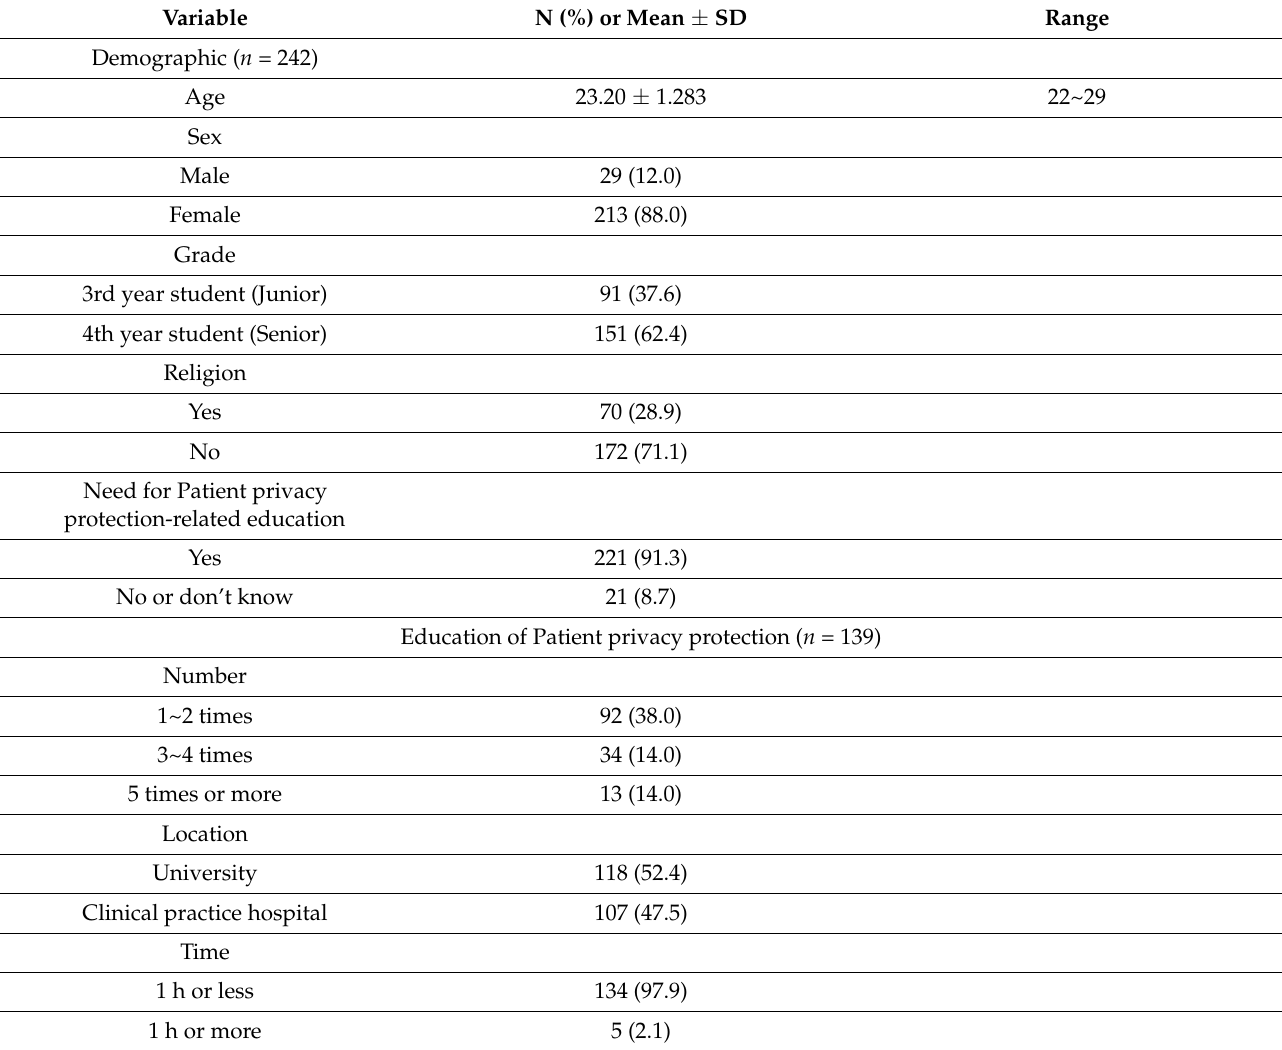
Table 1. General characteristics and patient privacy protection education (N = 242).